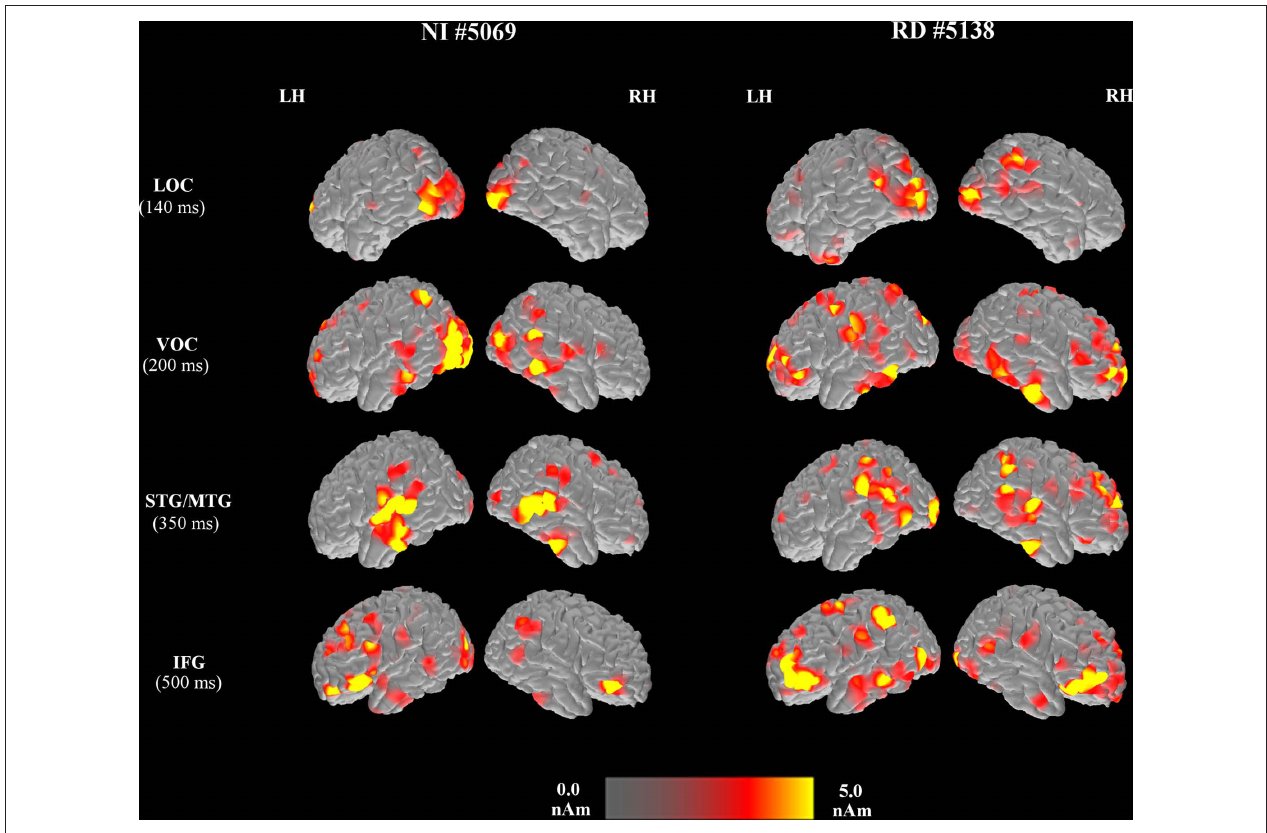
(VOC), superior/middle temporal (STg/MTg), inferior frontal (IFg), and middle frontal regions of the left (LH) and right (RH) hemispheres. The latency, post-stimulus onset that each map was obtained is noted next to the ROI label. Values represent “raw” estimated current (without subtracting the peristimulus current for each